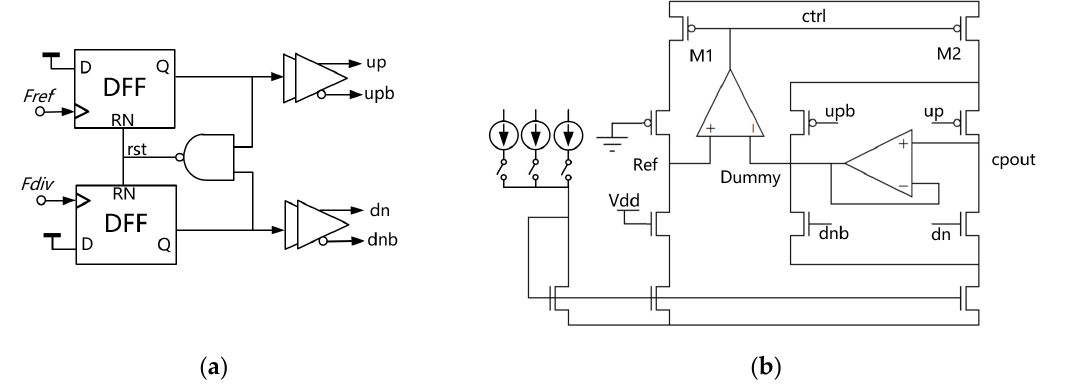
Figure 6. Schematic of ( a ) the phase-frequency detector; ( b ) the charge pump with dual Op-Amp design for matching up-and-down currents.